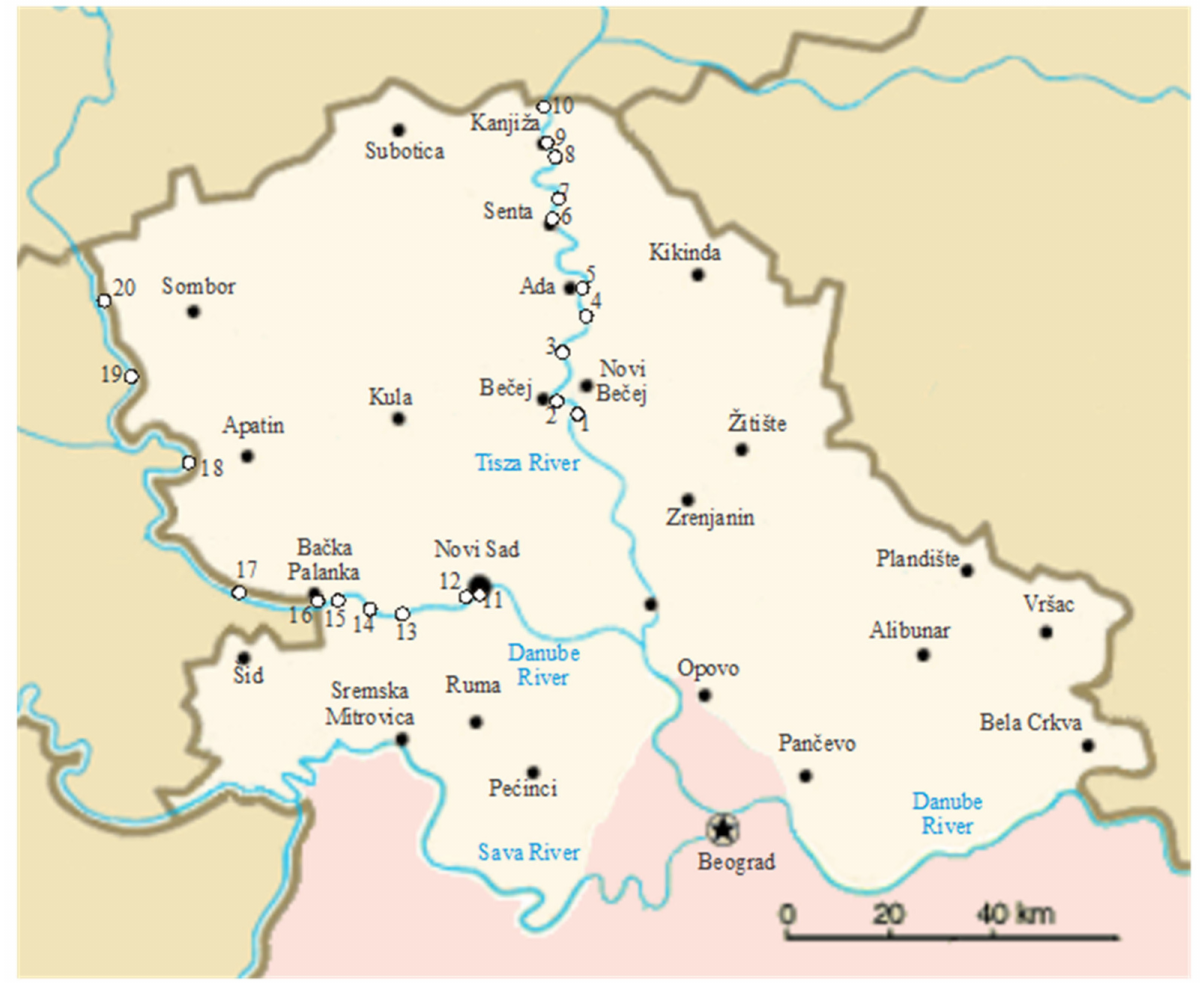
Figure 1. Location of sampling sites in the Tisza River (samples 1–10) and Danube River (samples